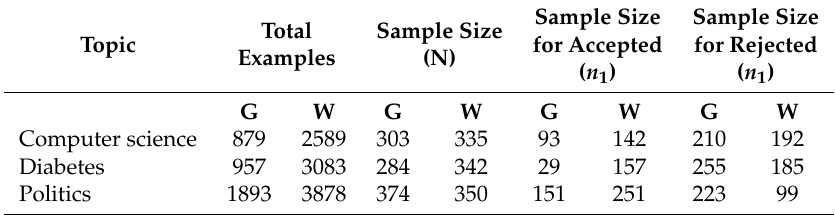
Table 9. Sample size calculation for accepted and rejected web pages. G is for Google data and W is for Wikipedia data.